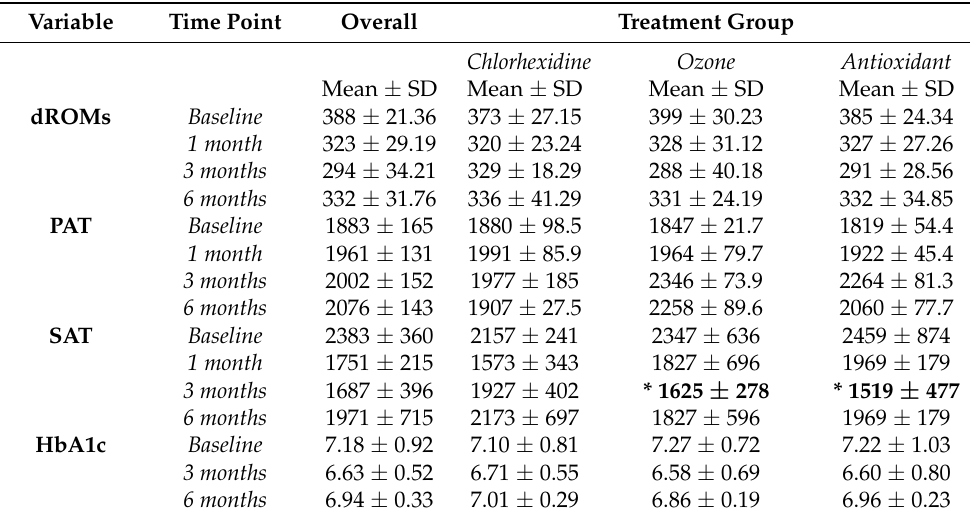
Table 3. The outcome measures for reactive oxygen metabolites (dROMs, PAT, SAT) and glycated hemoglobin (HbA1c) were measured at baseline and at one, three, and six